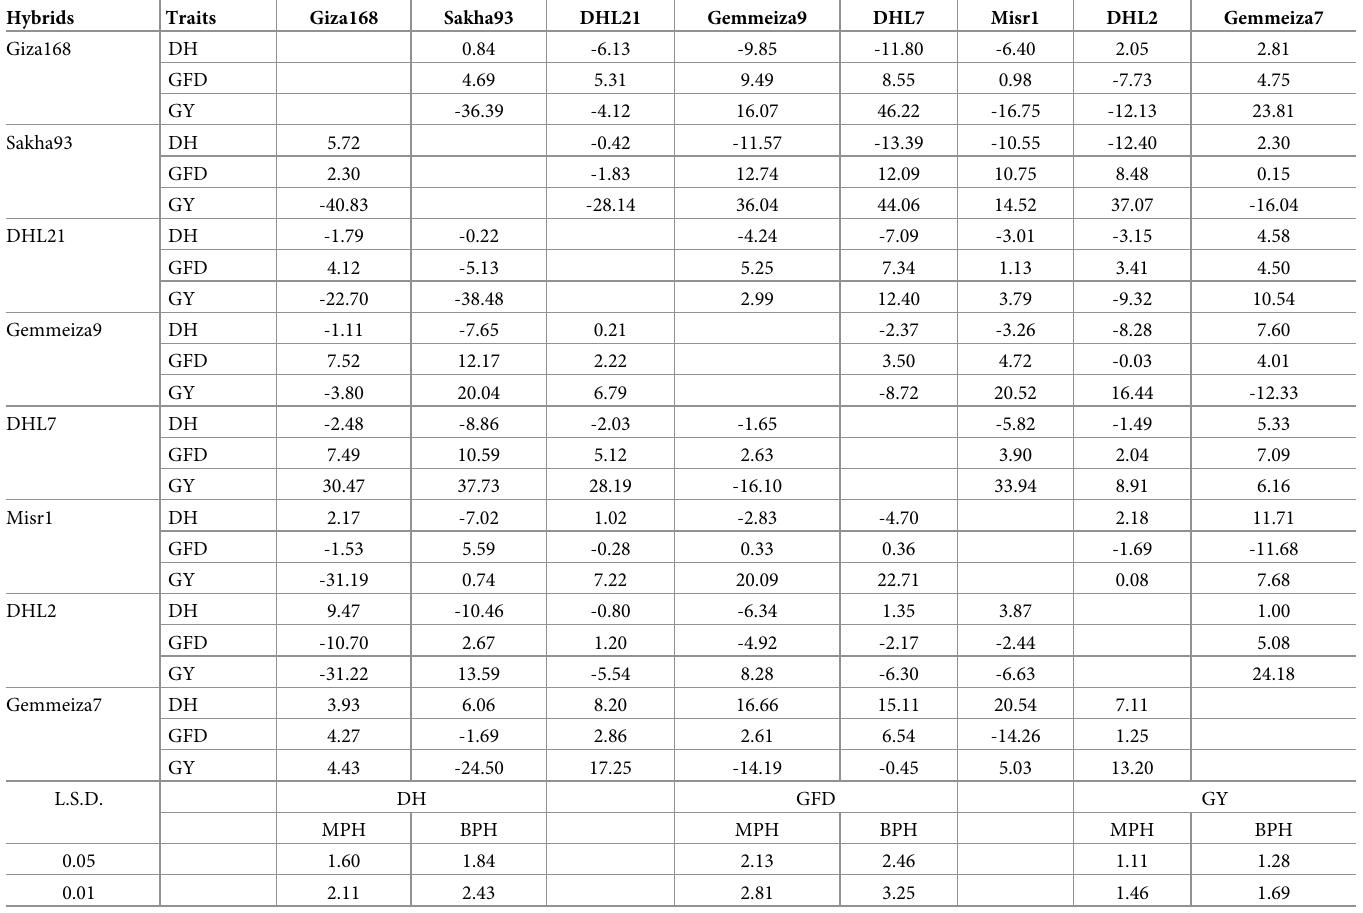
Table 3. Mid-parent heterosis (upper right) and better-parent heterosis (lower left) in F 1 hybrids for days to heading, grain filling duration, and grain yield for com- bined data across